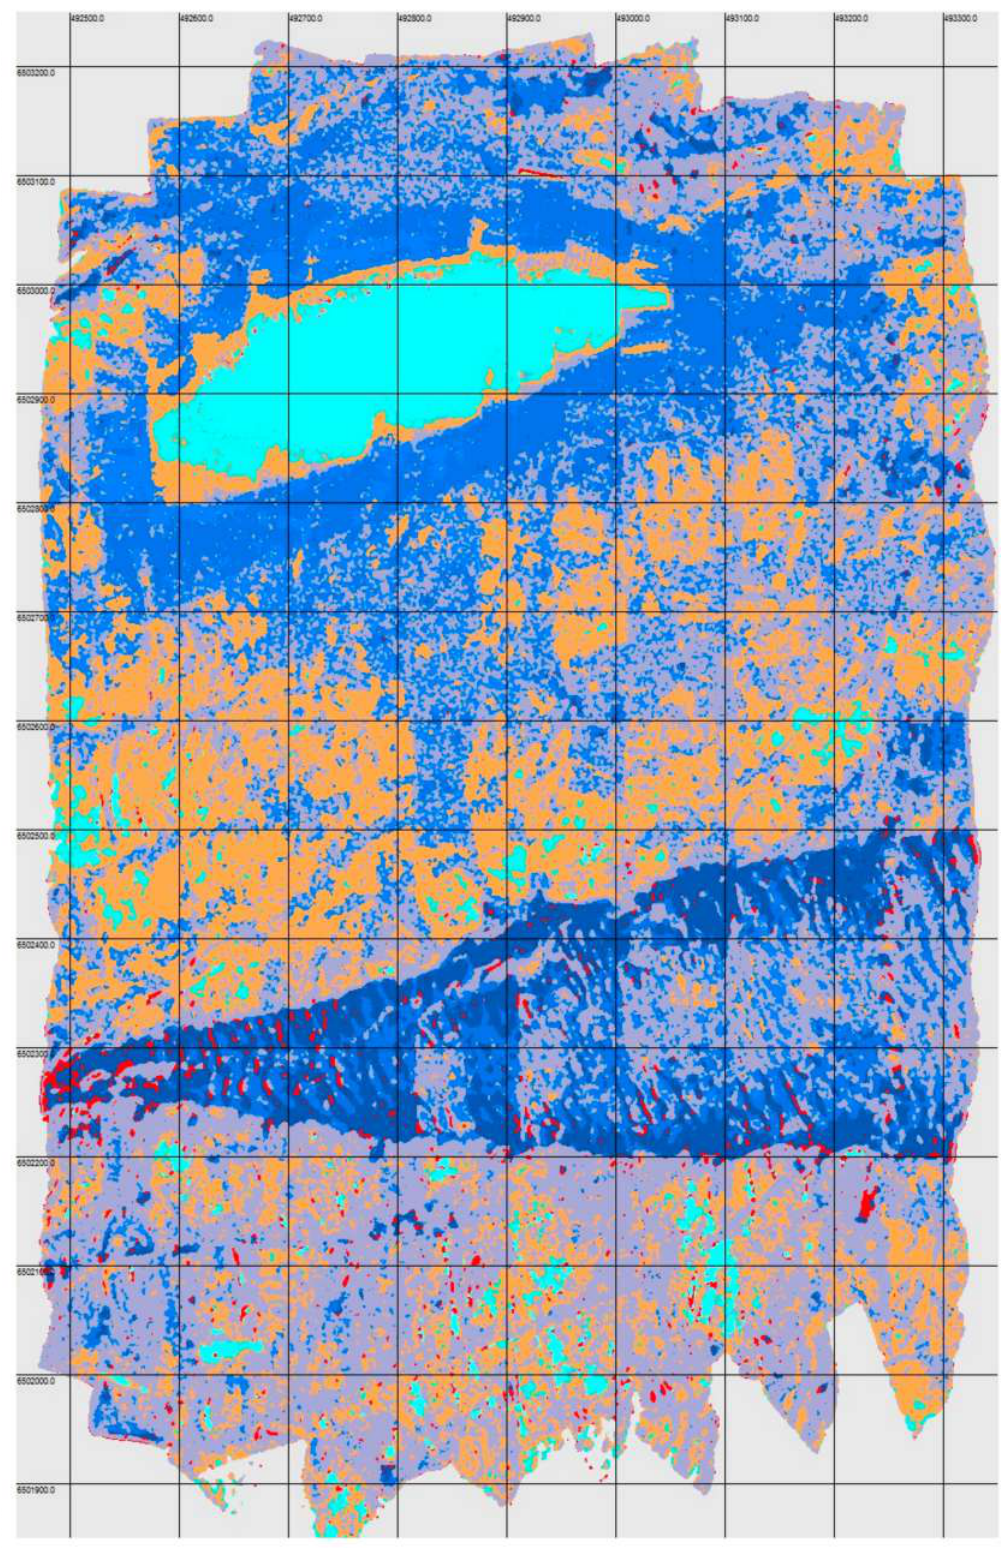
Figure 5. Inner Sound, Pentland Firth. A user-supervised texture-mapped image of the colour sonar image reduced to greyscale shown in Figure 4 generated using (Kongsberg) GeoTexture software. The grid lines are at 100 metre intervals. The legend for the figure is given in Table